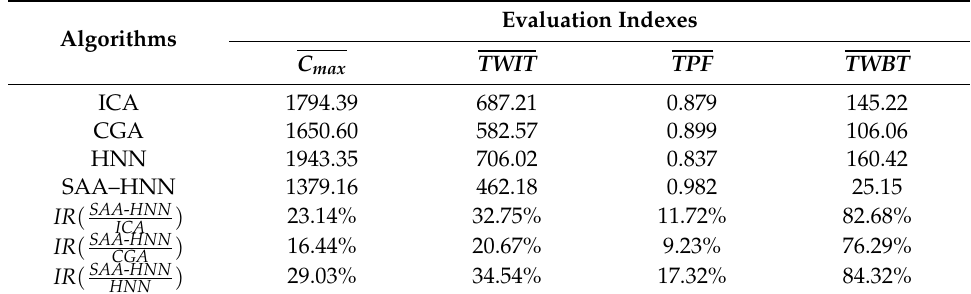
Table 7. Comparison of the evaluation indexes of four algorithms’ scheduling results (large-scale data).